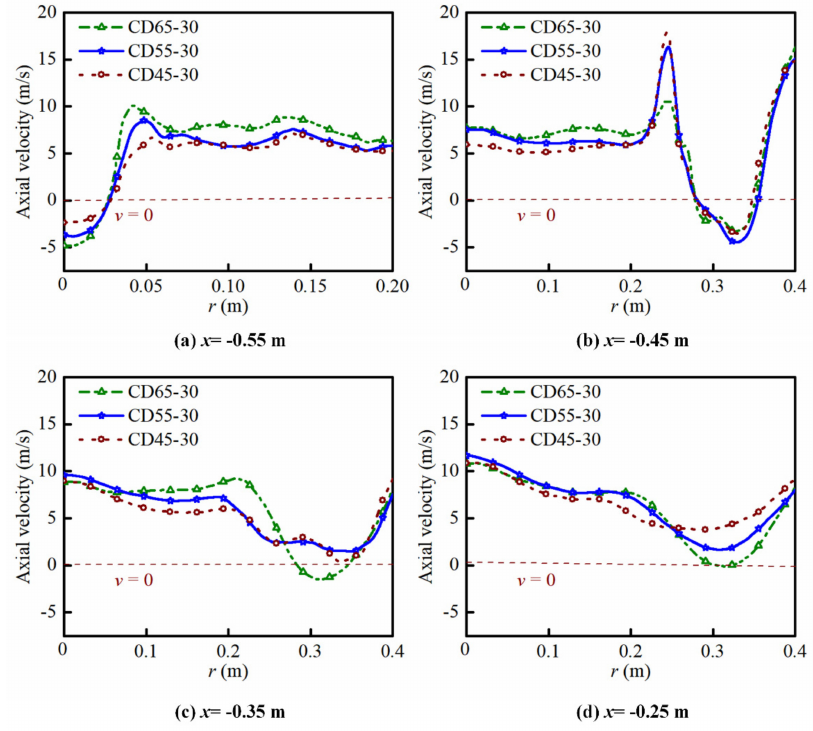
Figure 12. Axial velocity of CD65-30, CD55-30, and CD45-30 at different axial